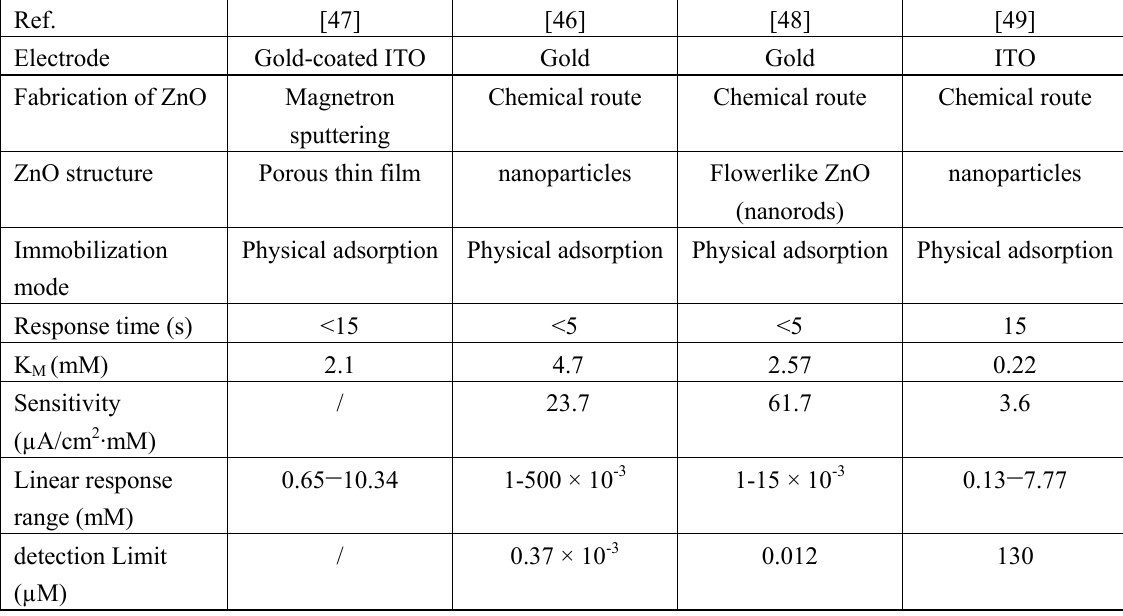
Table 4. ZnO-based electrochemical biosensors for cholesterol detection (cholesterol oxidase as enzyme) (ITO: Indium tin oxide; “/” in the table means the corresponding content is not